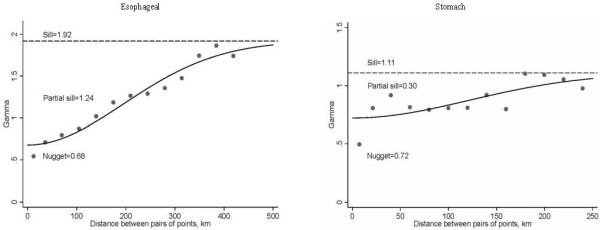
Gaussian semivariograms fit to the residuals-based empirical semivariograms for both sexes combined in esophageal and gastric cancer.